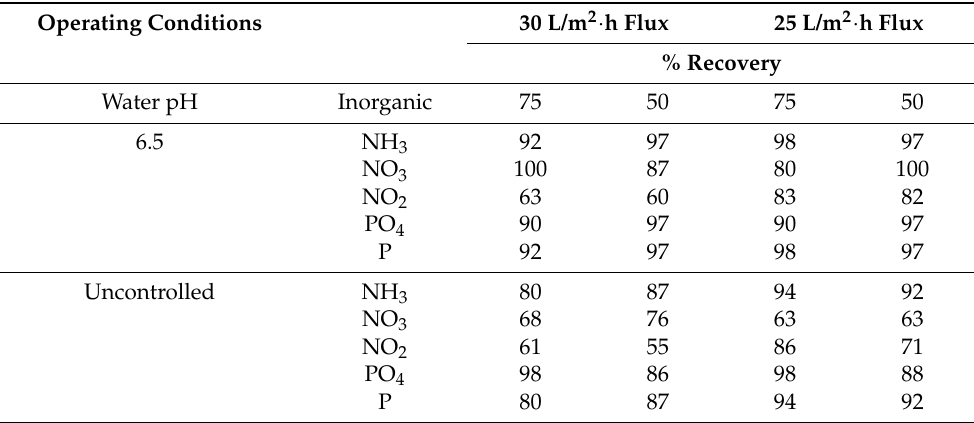
Table 6. Selected inorganics percentage removal using RO